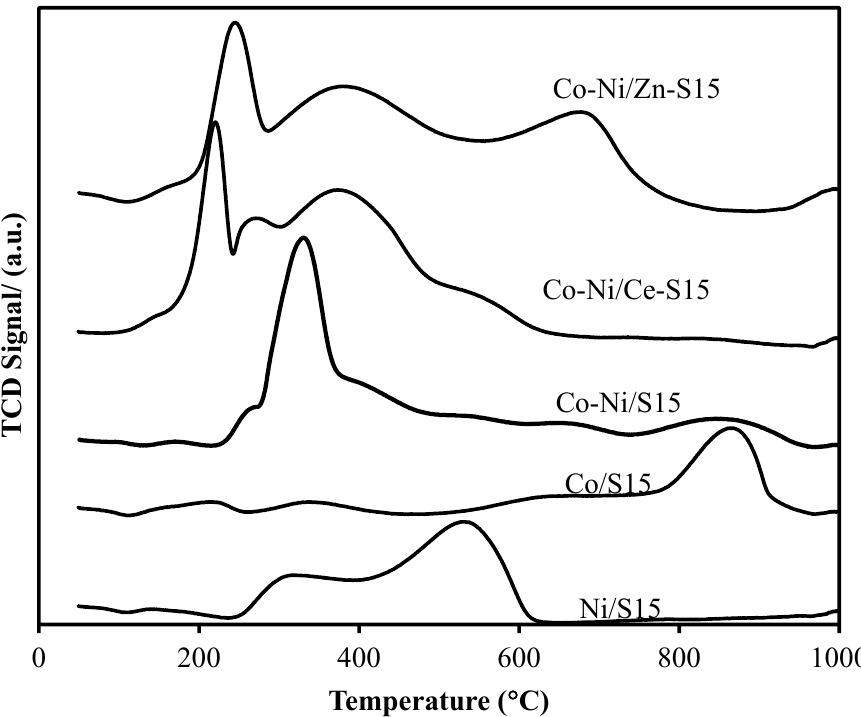
Figure 3. Temperature-programmed reduction using a mixture of hydrogen and argon.